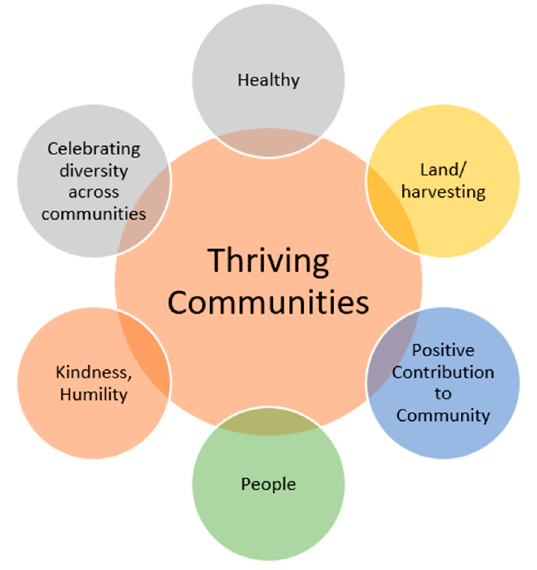
Figure 2. Elements of thriving Arctic communities.